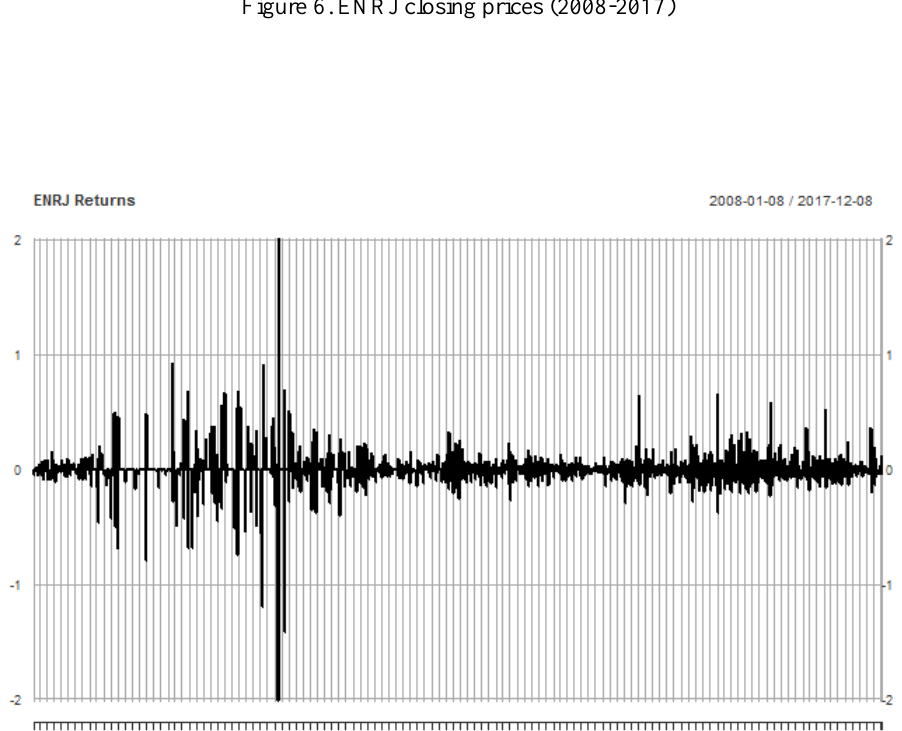
Figure 7. ENRJ returns